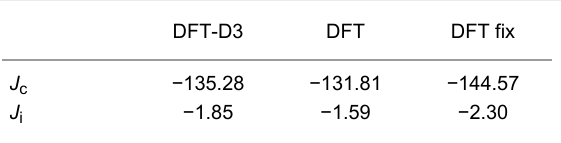
Table 3: Calculated coupling constants (in meV) based on the DFT-D3 energies by using the fully optimized geometries (DFT-D3), the pure DFT energies without D3 correction (DFT), and the DFT energies obtained by using the fixed AF3 ground-state atomic structure (DFT